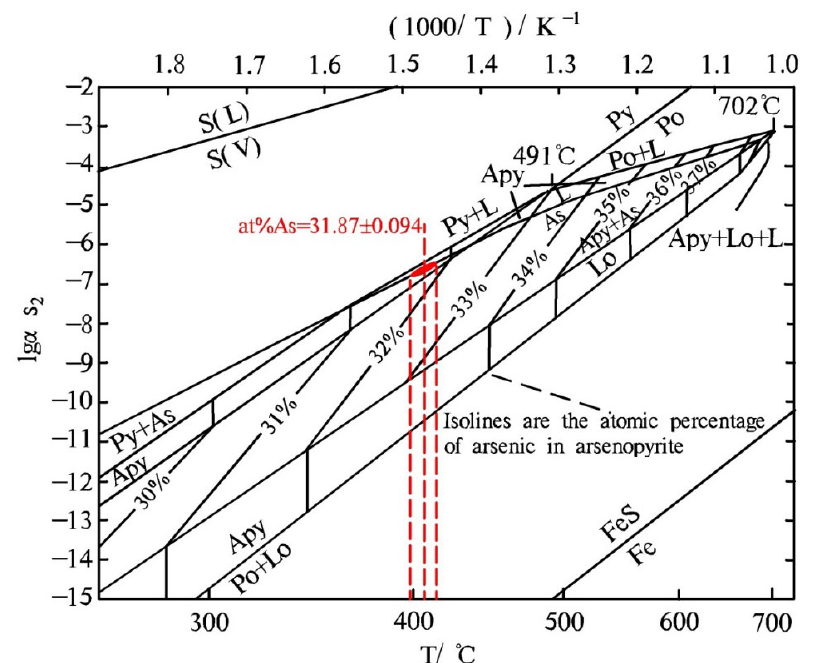
Figure 5. The relationship between sulfur fugacity and temperature in the stable area of